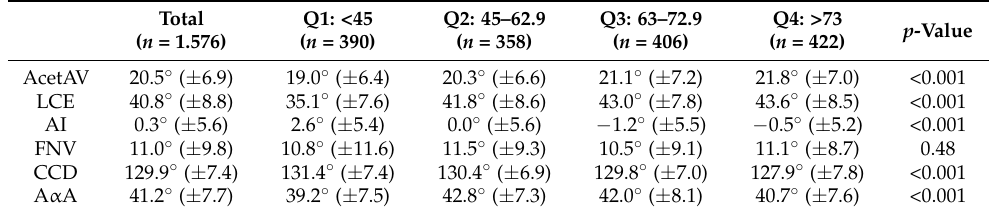
Table 3. Mean values of acetabular and femoral morphological parameters for different age